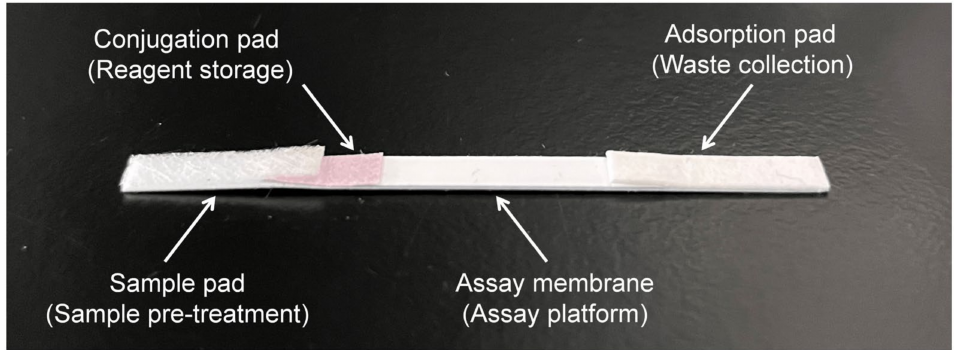
Figure 1. The component and illustration of the ICT